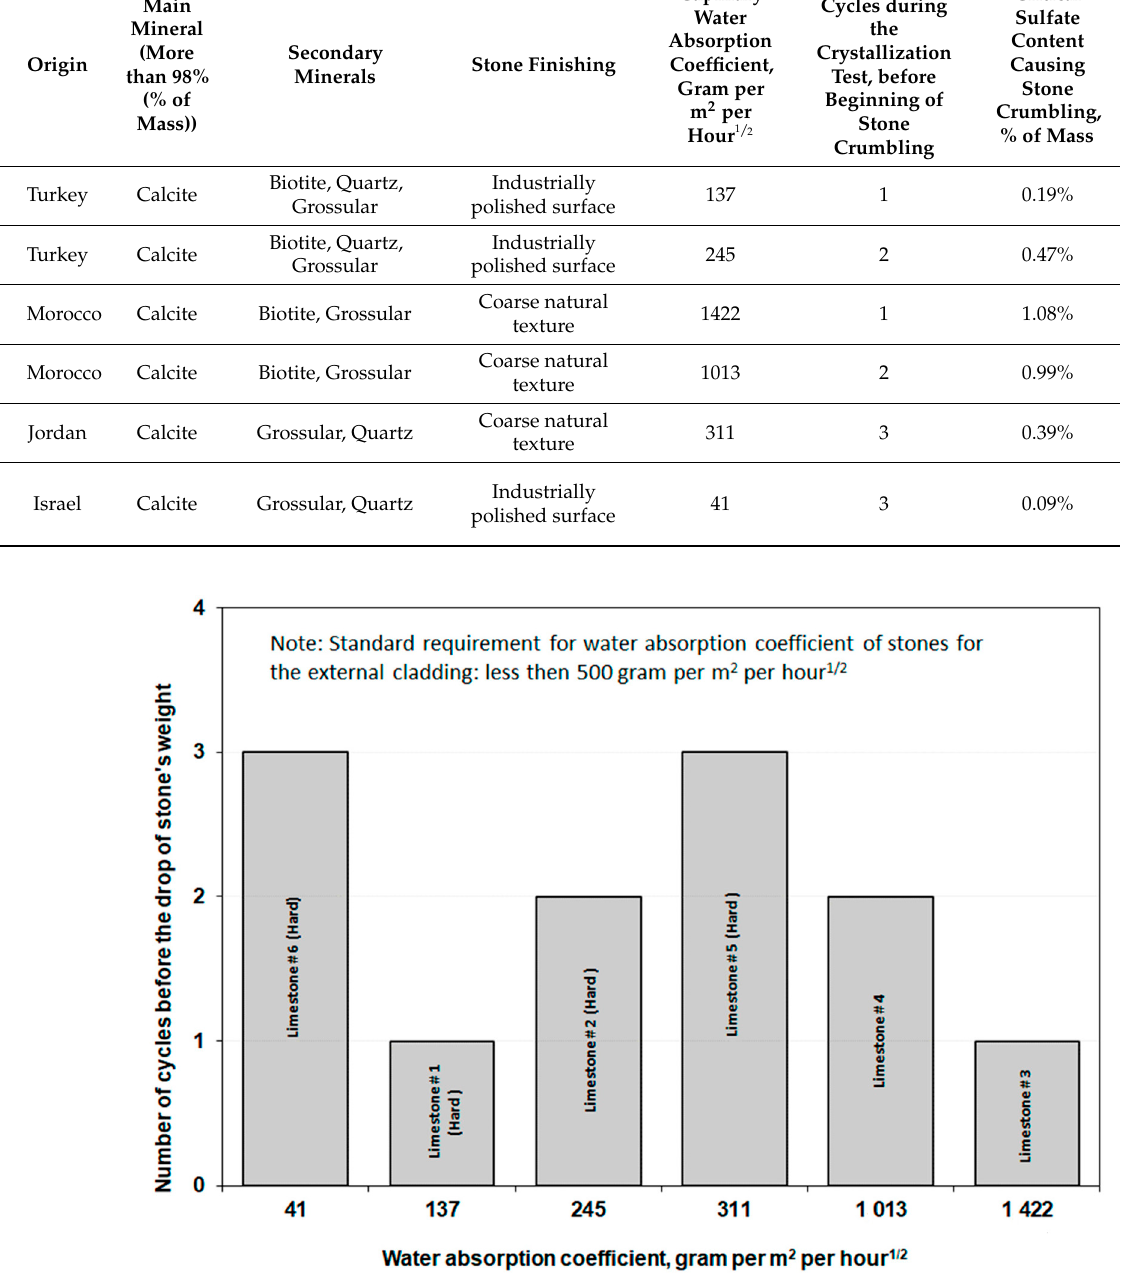
Figure 3. Relationship between capillary water absorption and cycles elapsed before stone crum- bling.